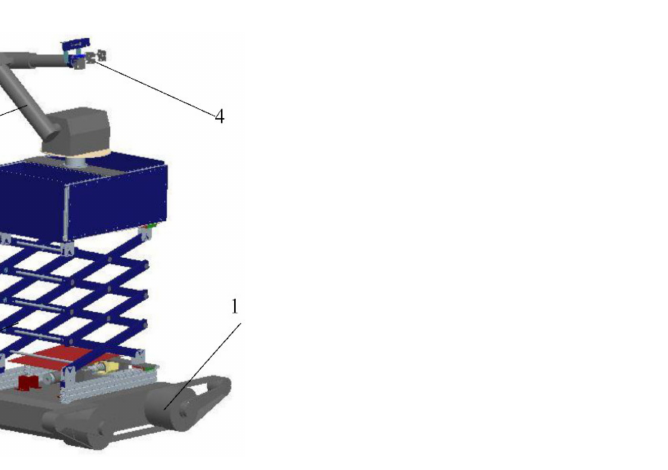
Figure 12. Citrus picking robot with a crawl moving system and a shear forklifting and arm manipu- lator: 1, crawler; 2, shear forklift; 3, 2-DOF arm manipulator; 4,